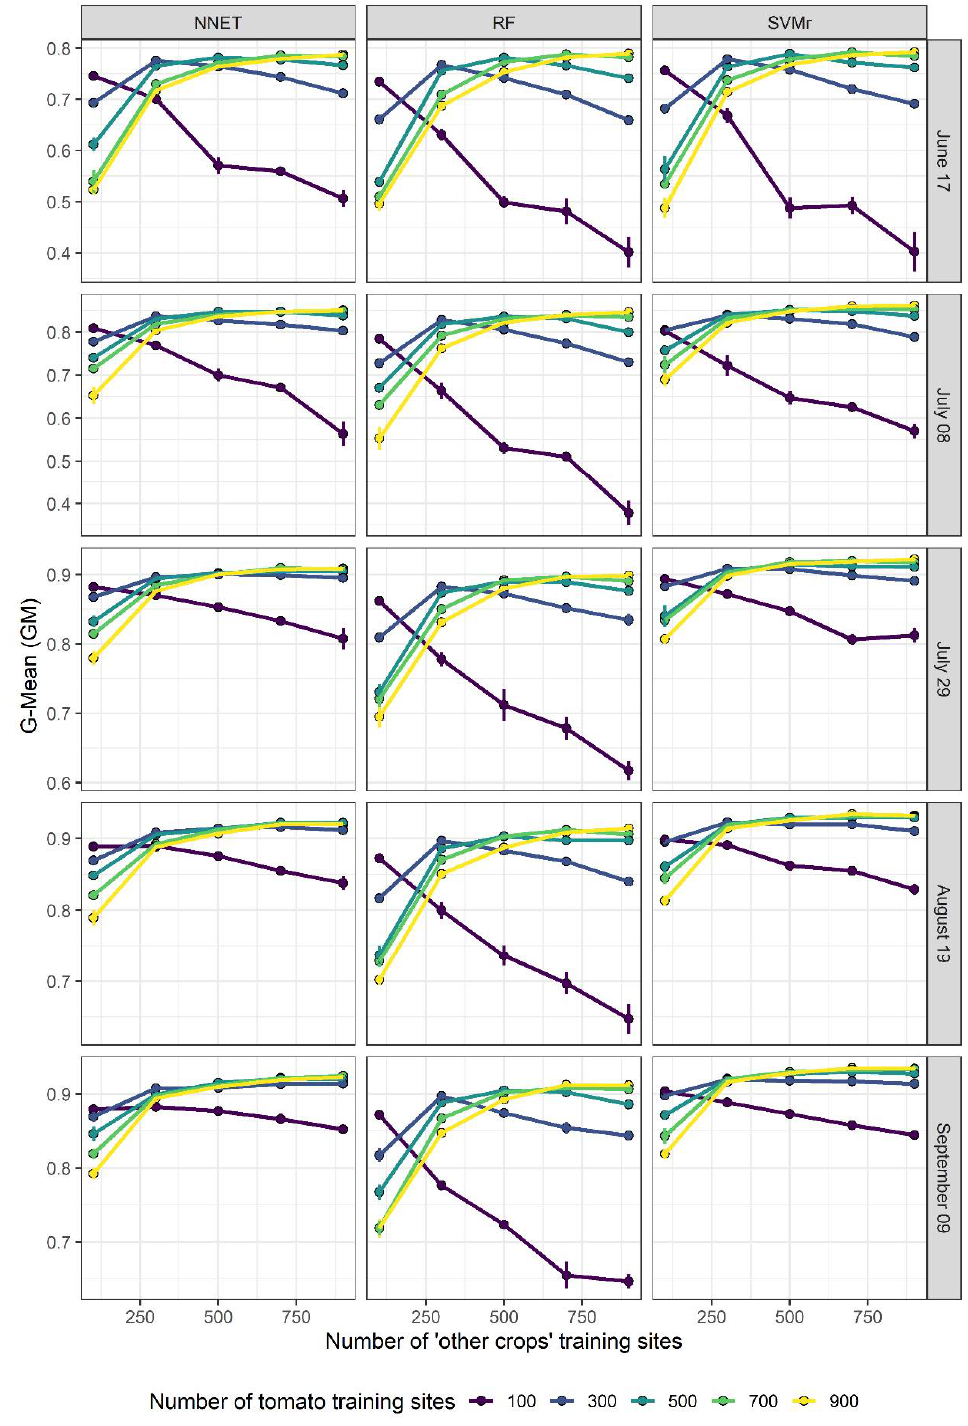
Figure 4. G-Mean progress over the number of ‘other crops’ training sites at different numbers of tomato training sites and lead time.